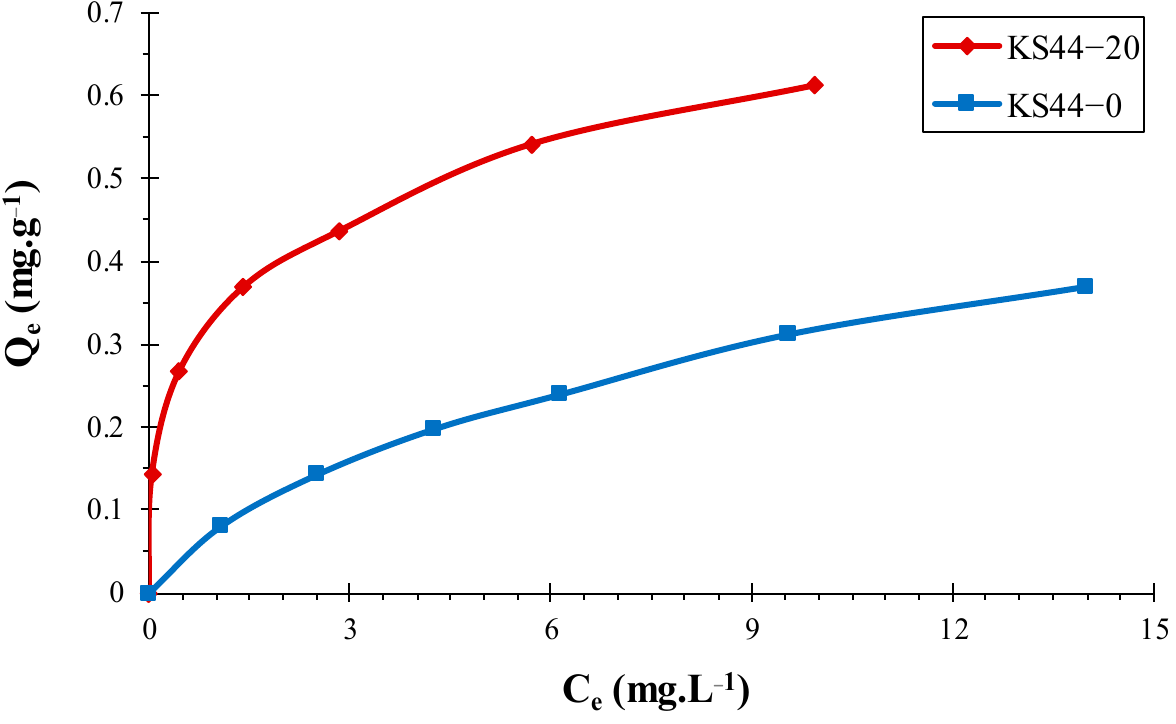
Figure 7. Adsorption isotherms of RhB on carbon composites ( a ) KS44 ‐ 0 and ( b ) KS44 ‐ 20. (T = 20 °C,